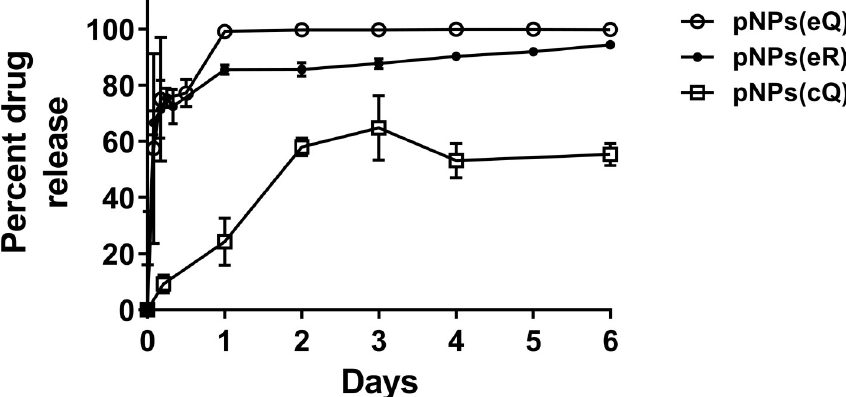
Fig 3. Measures of percent drug release from pNP containing entrapped quercetin (pNP(eQ)), covalently attached quercetin (pNP(cQ)) and entrapped rhamnazin (pNP(cR)). Protracted release was observed mainly for pNPs(cQ). Data are means ± SD for n =